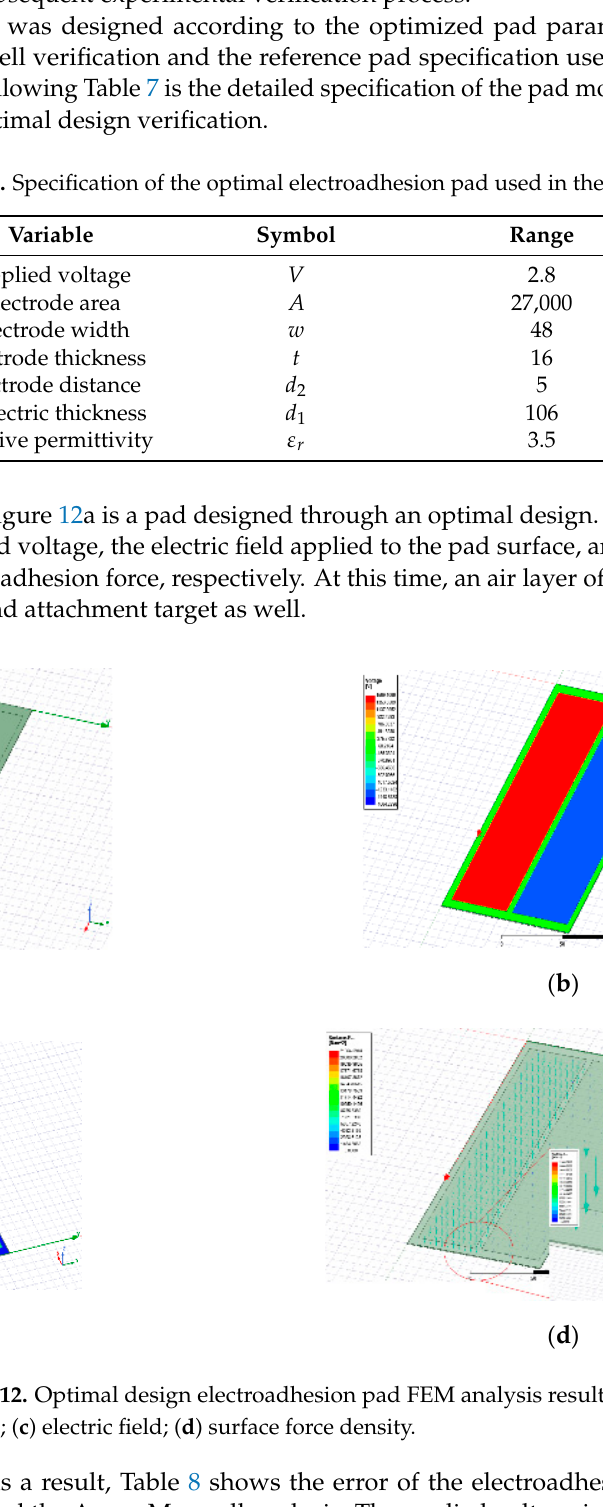
Table 8. Optimal design and analysis verification: error.